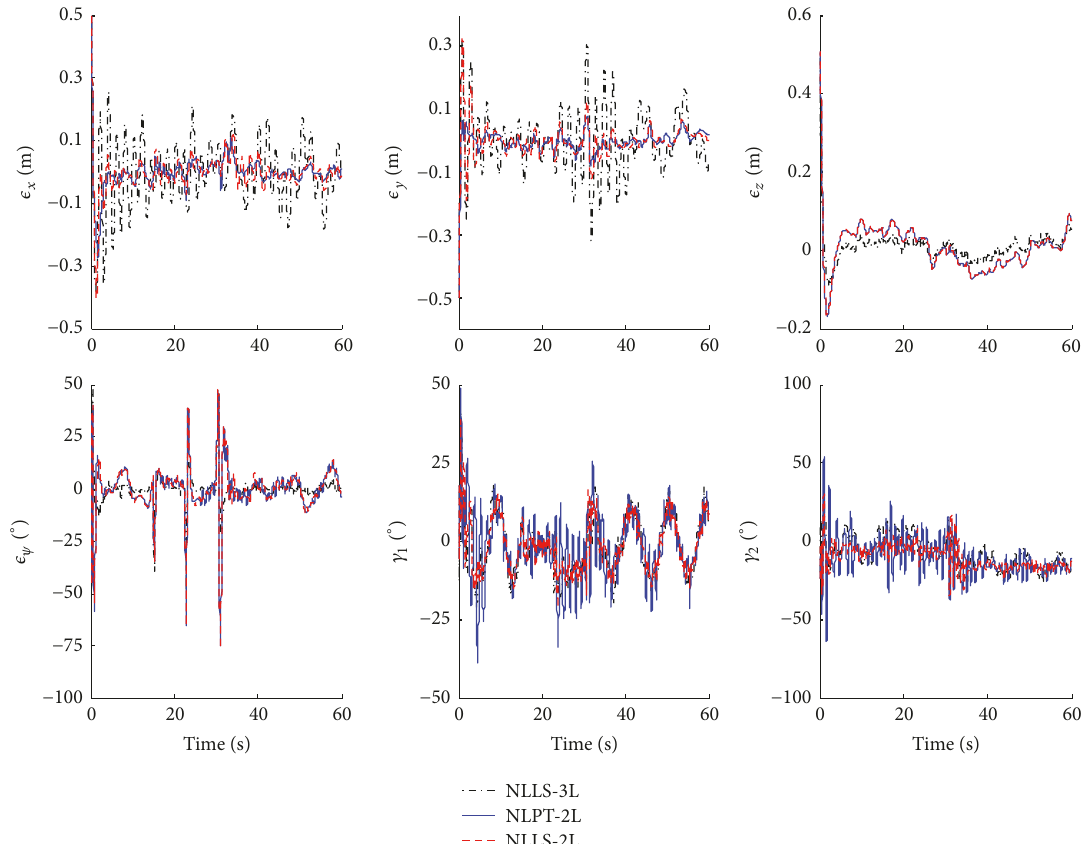
Figure 7: Tracking error and load swing on NLPT-2L, NLLS-2L, and